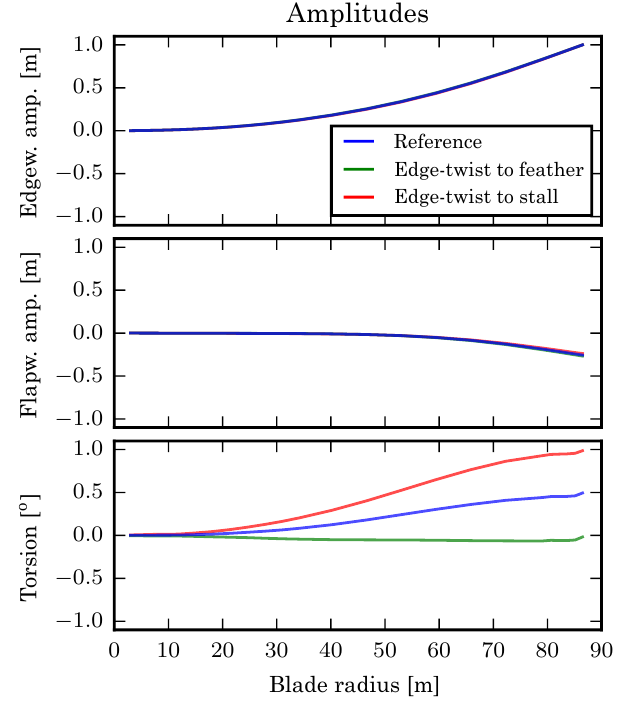
Figure 6. Structural mode shape of the first flapwise mode for the reference blade, and flap–twist coupled blades with constant cou- pling coefficients of γ y = ± 0 . 1. Positive coupling coefficients de- note twist to stall for flapwise deflection towards the suction side. The amplitudes are normalized to 1m tip deflection in the flapwise